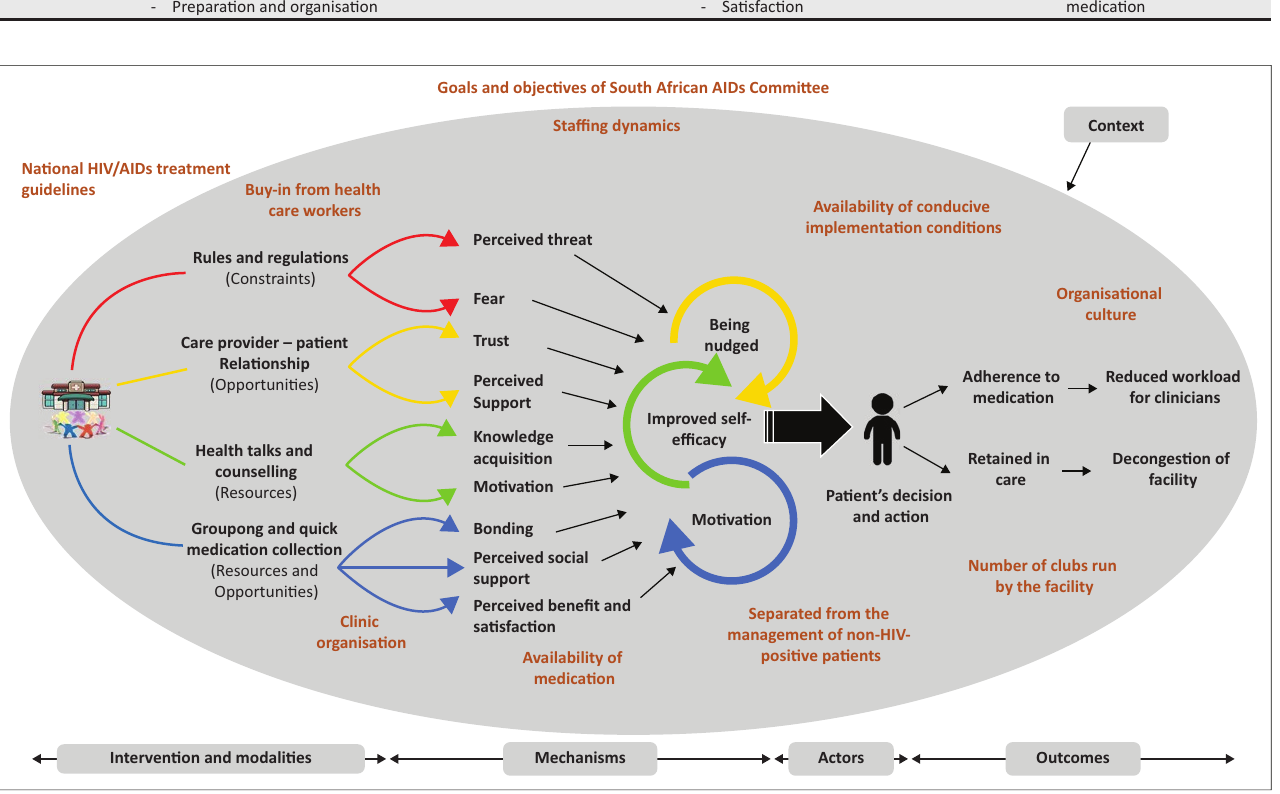
FIGURE 4: Modified programme theory.